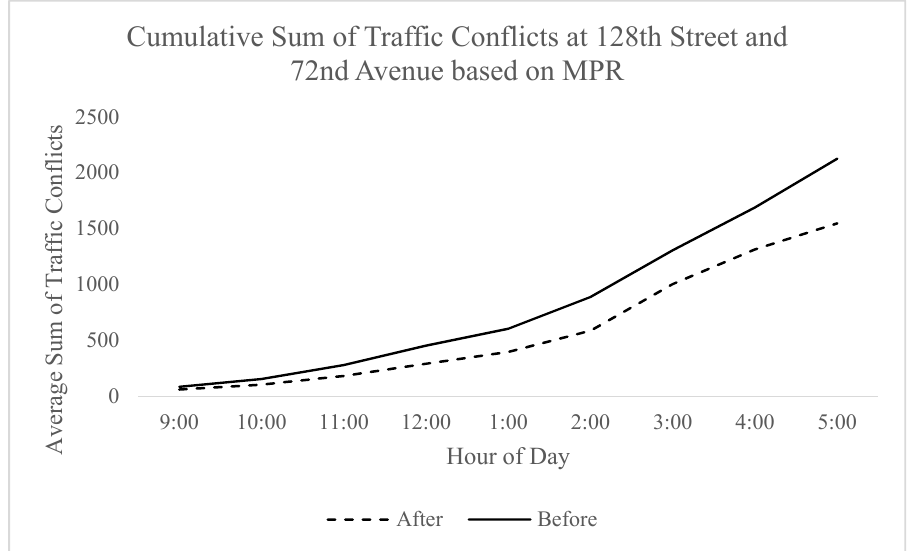
Figure 7. Variation of conflict rate per hour on 128th Street and 72nd Avenue.